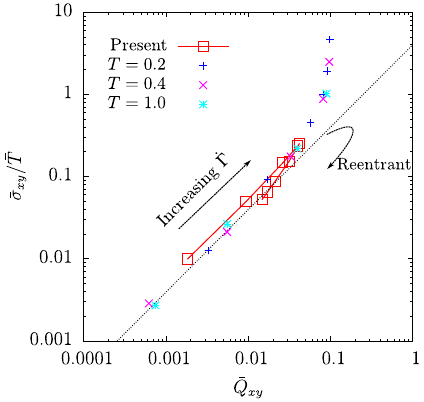
¯ Q ¯ T vs xy . The squares